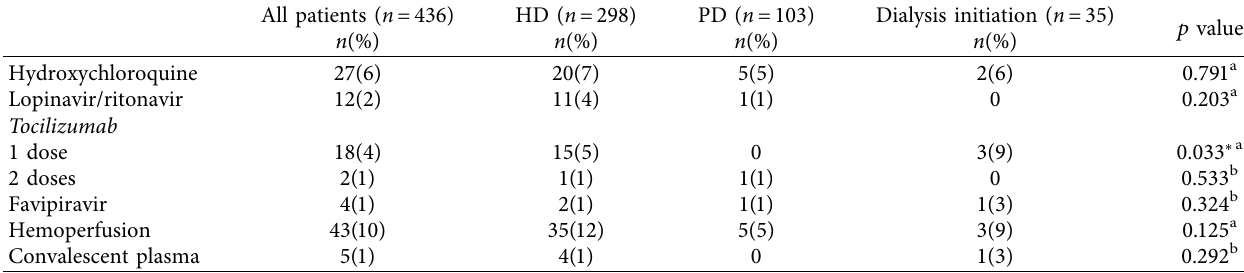
Table 3: Treatment given to CKD V patients with COVID-19 ( n � 436).